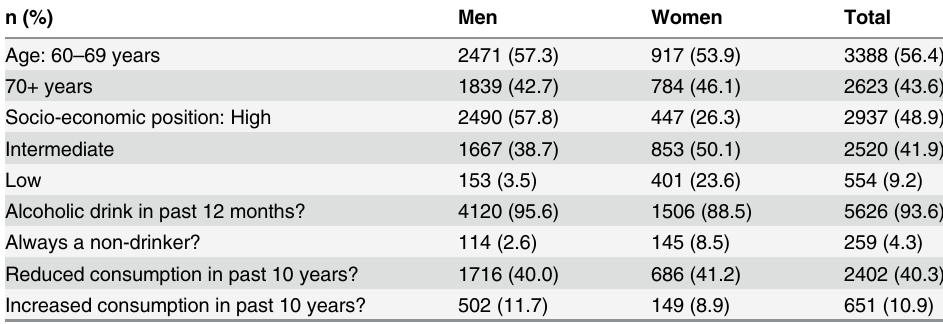
Table 1. Characteristics of participants at phase 11 of the Whitehall II